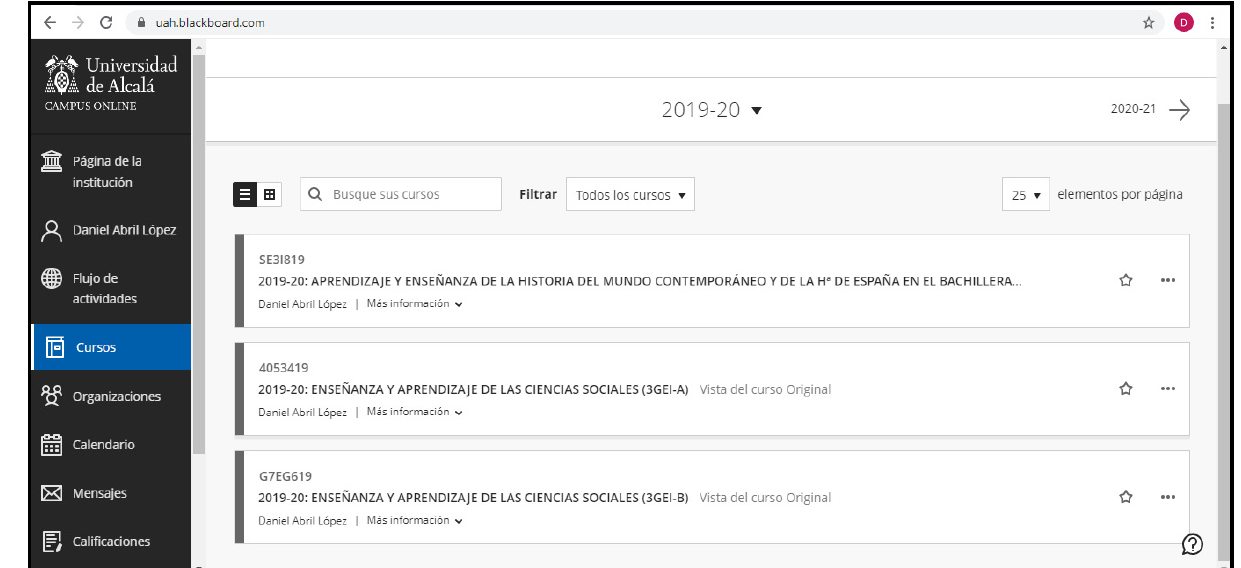
Figure 2. Blackboard Learn from teacher trainer Daniel Abril-López (2019–2020 academic year).